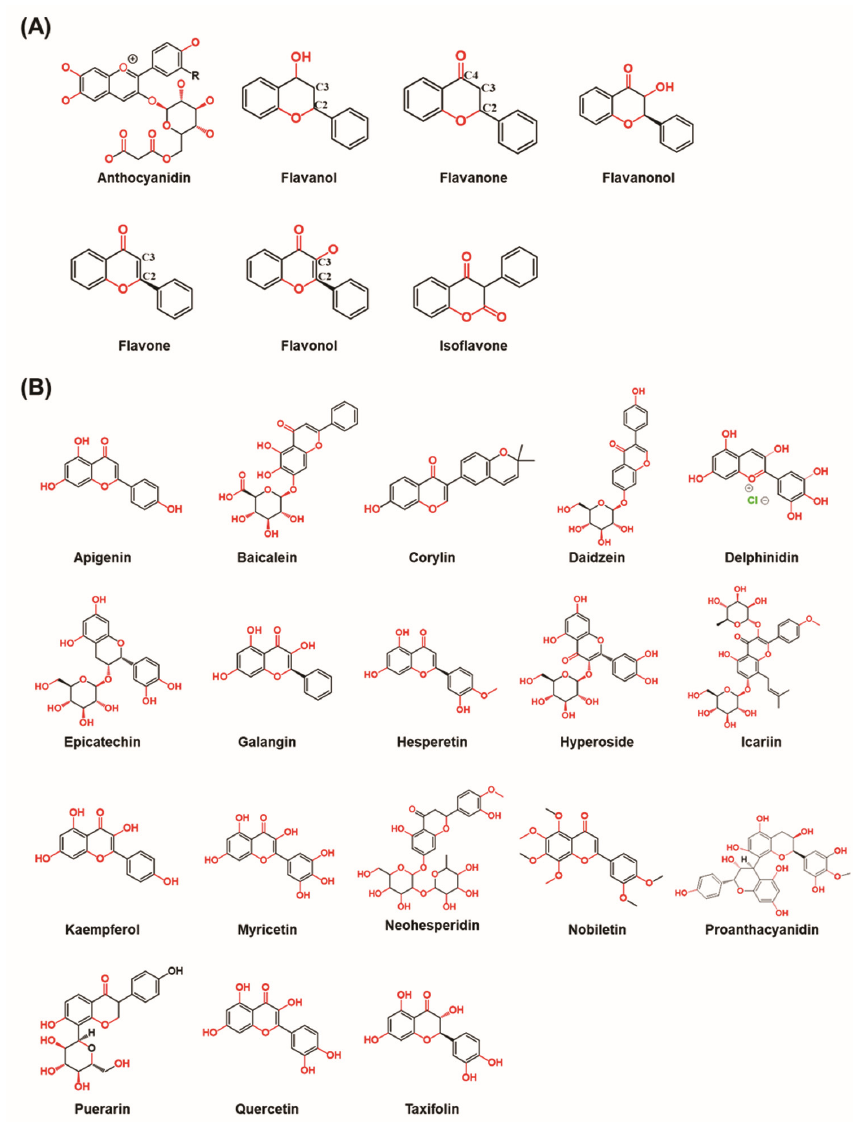
Figure 1. The chemical structures of flavonoids. ( A ) The chemical structure of different types of flavonoids. ( B ) The chemical structure of flavonoids involved in the different bone–related signaling pathways. (Chemical structures source: PubChem (NCBI, NIH, USA; https://pubchem.ncbi.nlm.nih.gov/) accessed on 7 February 2023).